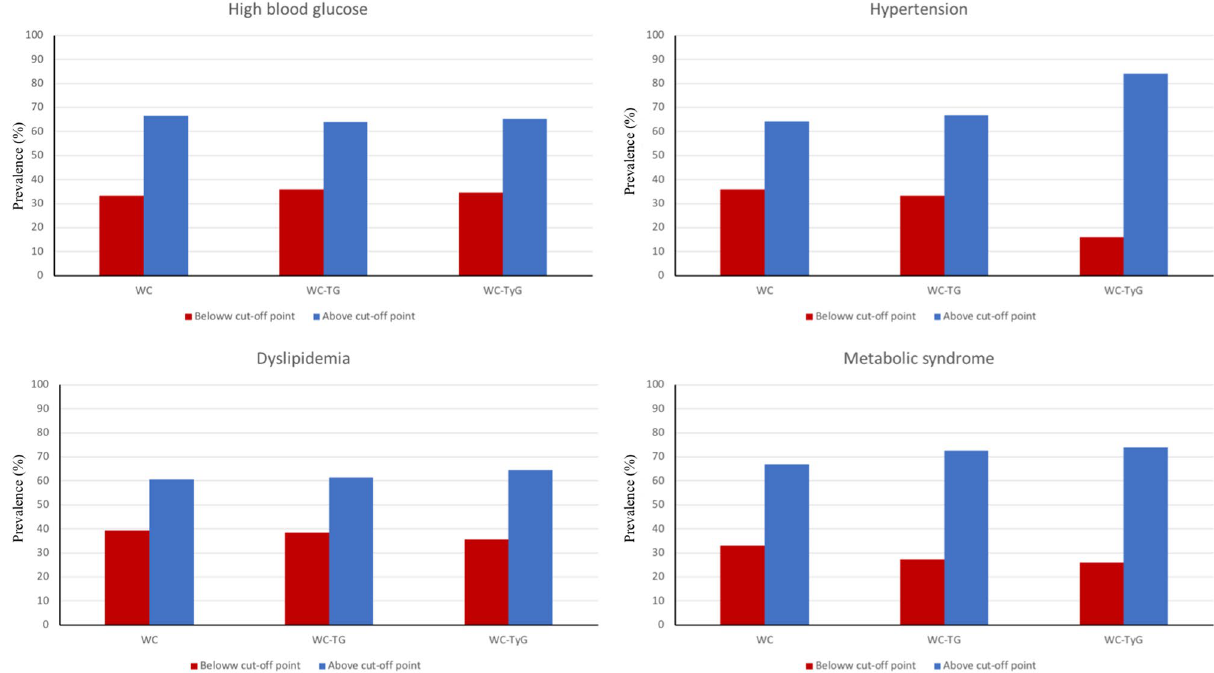
Figure 2. Prevalence of the metabolic syndrome and individual manifestations components according to the designed cut-off